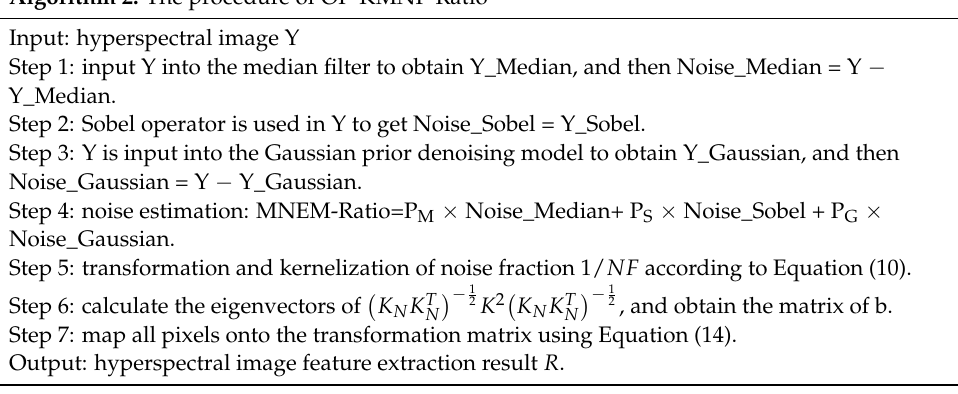
Algorithm 2. The procedure of OP-KMNF-Ratio